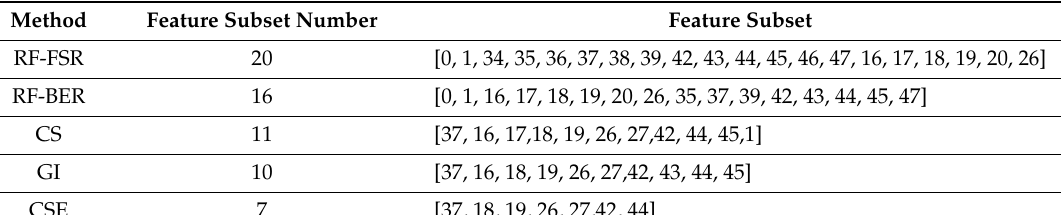
Table 7. Comparison of feature selection algorithms for UDP flow datasets.